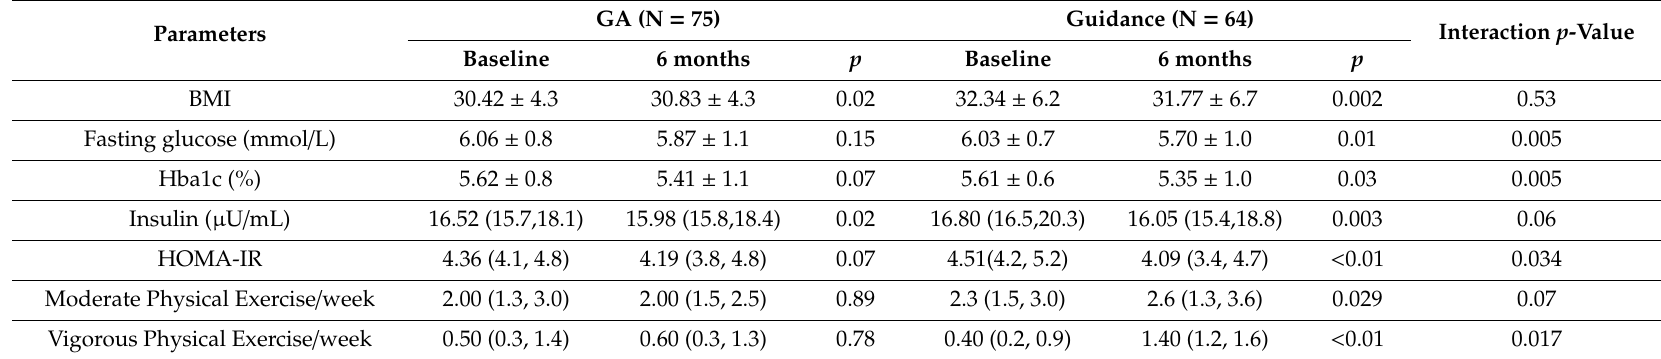
Table 2. Body mass index (BMI), glycemic profile, and physical activity changes of groups over time.